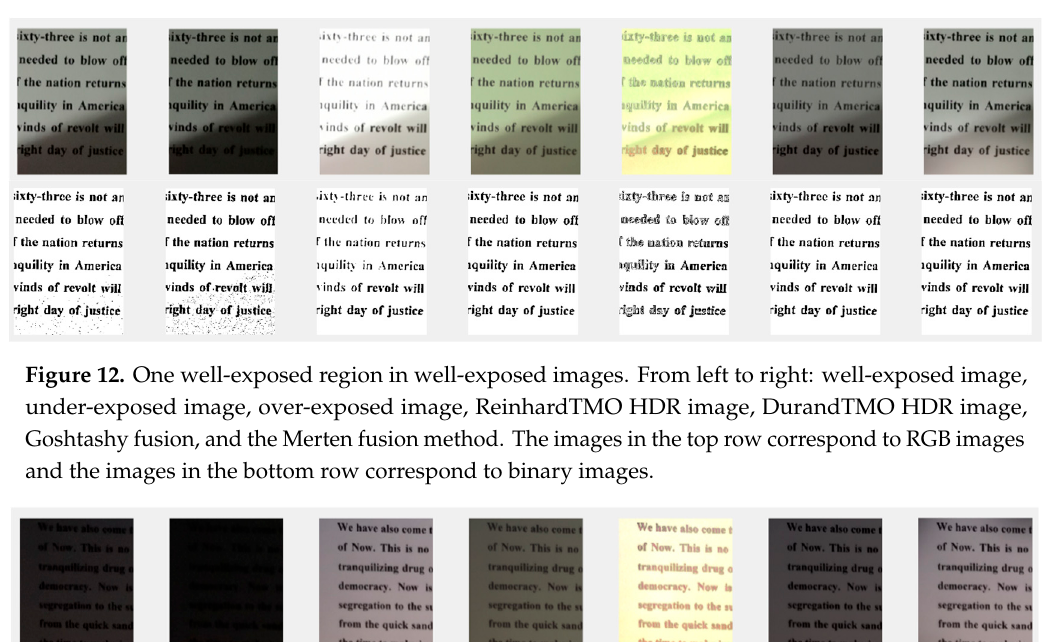
(b) Figure 11. HDR fusion method: ( a ) Mertens’ method ( b ) Goshtashy’s method. 4. Experiments In order to have a more objective evaluation of improved image quality due to exposure bracketing as well as a more objective comparison of different HDR generation methods, we used two methods for comparison. First, we zoomed in different regions of the well-exposed image, corresponding to a well-exposed region, under-exposed region, and over-exposed region of the image, and we then compared these regions with the HDR images and fusion images. In the meantime, we also generated the binary images of these regions using the Sauvola method. The reason why we also considered a binary image is because it is the binary image that will be used for OCR. Figure 12 shows one of the well-exposed regions in the well-exposed image. It is very clear that in this region, the original well-exposed image has good image quality and the moderate uneven lighting will not affect the generated binary image as the Sauvola binarization method is an adaptive image processing method. The same region in the under-exposed image shows small deterioration, however this is not observable in the well-exposed image. All HDR images and fusion methods show decent results. Figure 13 shows one of the under-exposed regions in the well-exposed image. This is the situation where we can clearly see the advantage of using exposure bracketing. The under- exposed image and well-exposed image do not have decent image quality, leading to noisy binary images. All the images generated with exposure bracketing techniques lead to improved image